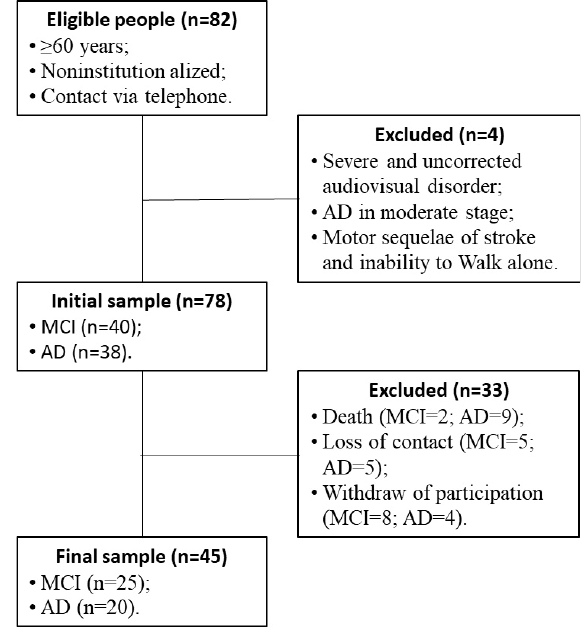
MCI: mild cognitive impairment; AD: Alzheimer’s disease. Figure 2. Flowchart of the sample.